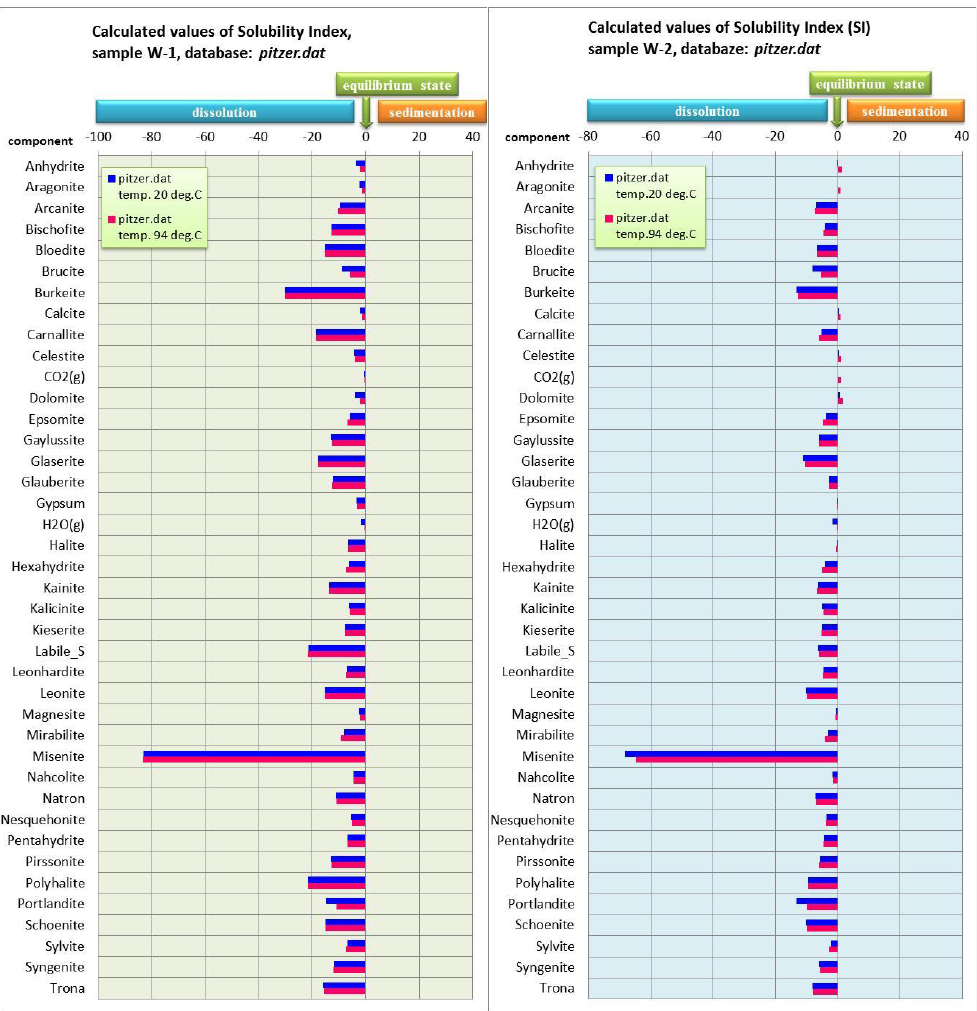
Figure 5. Comparison of SI calculated for W-1 and W-2 water samples using pitzer.dat database at 20 °C (ambient) and 94 °C (deposit) temperatures.